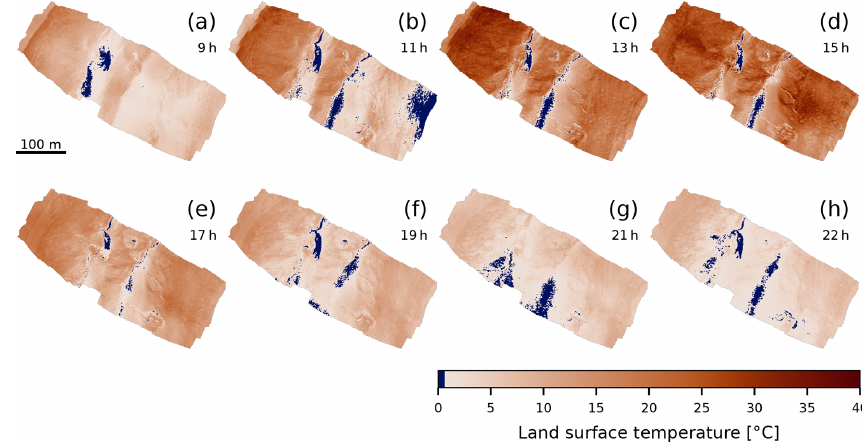
Figure 3. Spatiotemporal distribution of the land surface temperature (LST). Panels (a–h) show the eight individual flights, describing a large fraction of the diurnal land surface temperature variation. The maps have a spatial resolution of 15cm and are colorized in dark blue for LST < 0 . 5 ◦ C. Due to the residual uncertainties of the LSTs, ice surface geometries appear inconsistent with time. The southeast region of